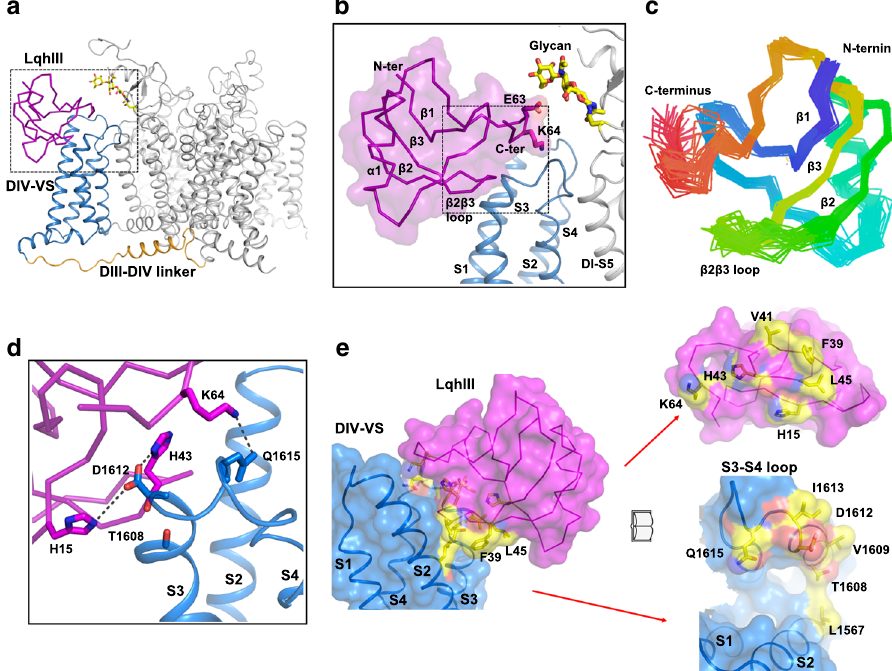
Fig. 3 Overall structure of rNa V 1.5 C /LqhIII complex and LqhIII binding site. a Cartoon representation of the overall structure of the Na V 1.5 C /LqhIII. LqhIII, D IV-VS and D III- D IV linker were colored in purple, blue and orange, respectively. The same color scheme is applied hereafter in this paper unless speci fi ed otherwise. The glycosyl moieties are shown in sticks colored in yellow. The black dash square is indicated for panel ( b ). b Zoom-in view of LqhIII binding to the D IV-VS. The black dash square indicated for panel ( d ). c The NMR structure of the LqhIII (PDB code: 1FH3) indicating the fl exibility of the β 2 β 3 loop and C-terminus. d Detailed interactions between LqhIII and D IV-VS. Key residues shown in sticks were labeled. Interaction surfaces of the D IV-VS (blue) and the LqhIII (purple). Key residues for the interaction shown in yellow shading and embedded